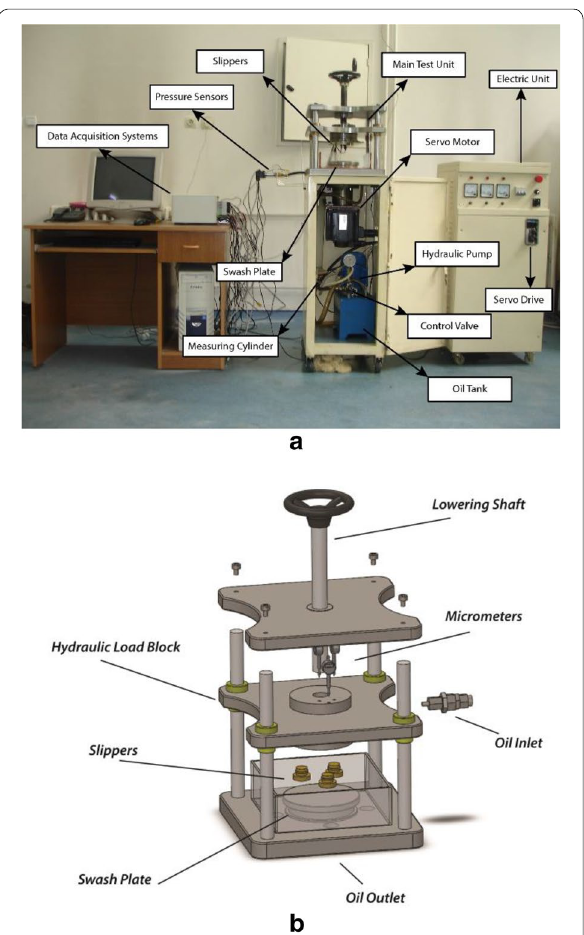
Figure 2 a Experimental setup and b schematic disassembly of the main test